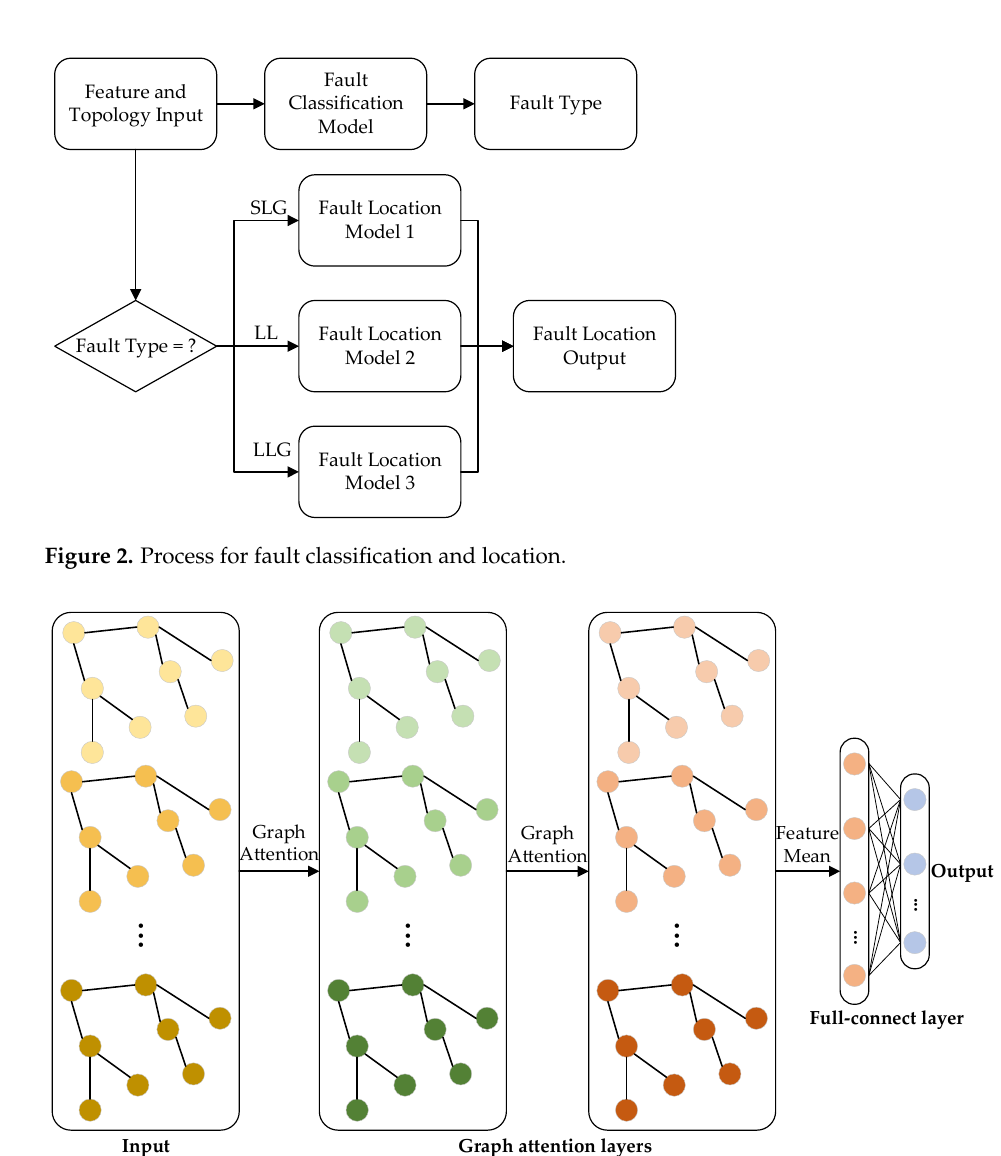
Figure 3. GAT-based universal model for fault classification and location.